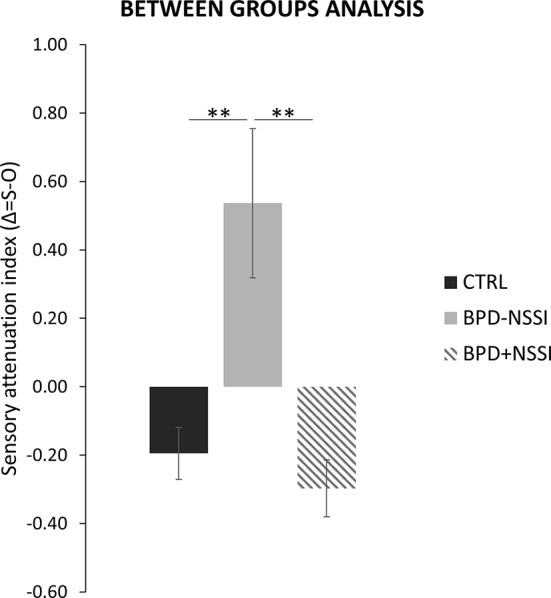
Between groups analysis. Significant differences in the sensory attenuation index between groups (CTRL in black; BPD-NSSI in gray, and BPD+NSSI in grey diagonal lines pattern). Error bars indicate sem. Asterisk indicates the significant comparison (** p < .005).